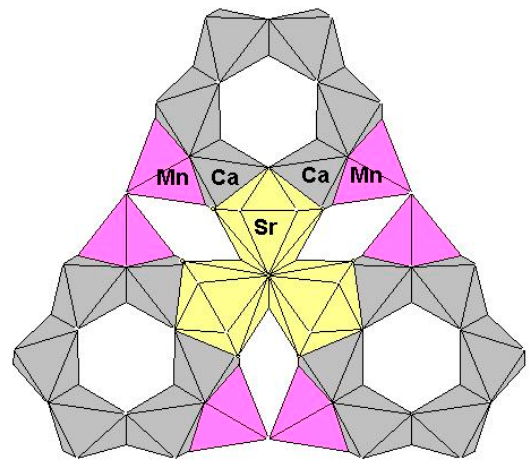
Figure 11. The layer formed by the M 1 Ca 6 , N 4 Sr 10 , and N 3 Mn 2 + 5 polyhedra in “eucolite” (Sr- and Mn-rich EGM viewed along (001) [27,34]).